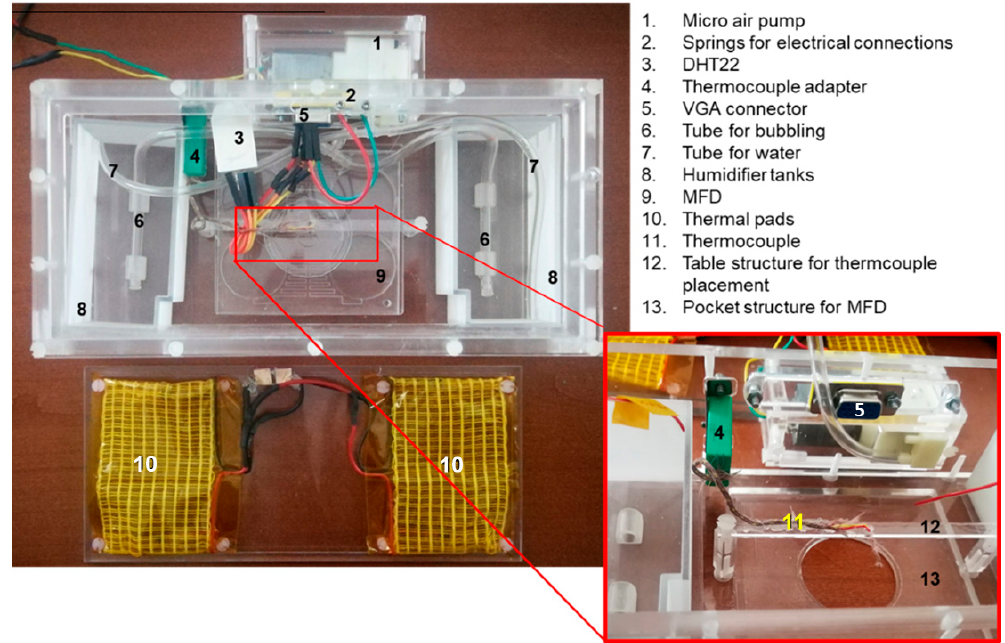
Figure 2. Experimental set-up used to characterize and validate the microfluidic device: mini-incubator and microfluidic device (MFD).